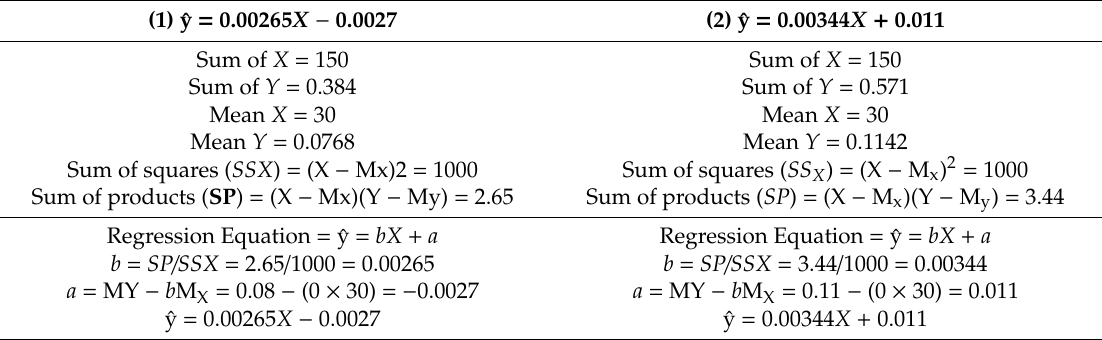
Table 1. Linear regression of the calibration curves for ( 1 ) AuNP-PEG-COOH and ( 2 ) AlPcS 4 Cl.